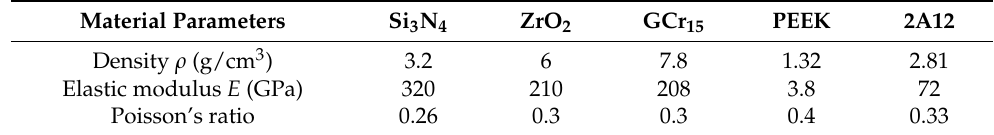
Table 1. Basic parameters of friction pair materials.